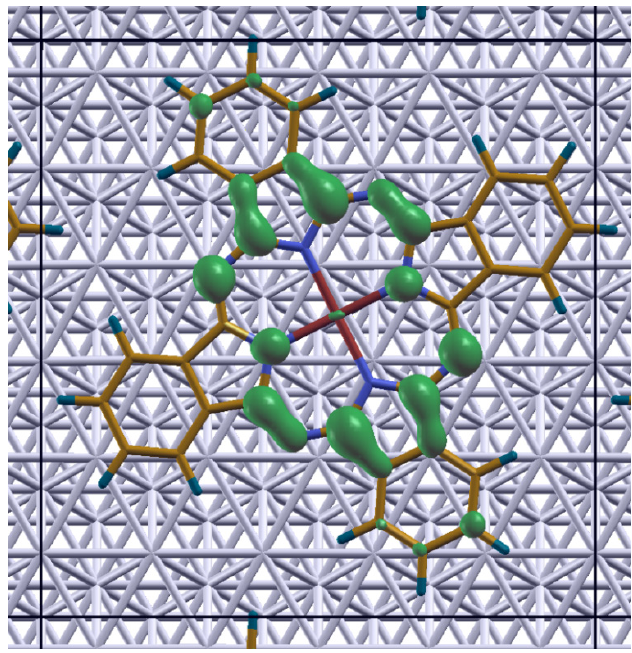
Figure 7. Isodensity plot of the local density of states of the CuPc molecule on Ag(111), calculated for an energy window with a width of 0.3 eV directly below the Fermi